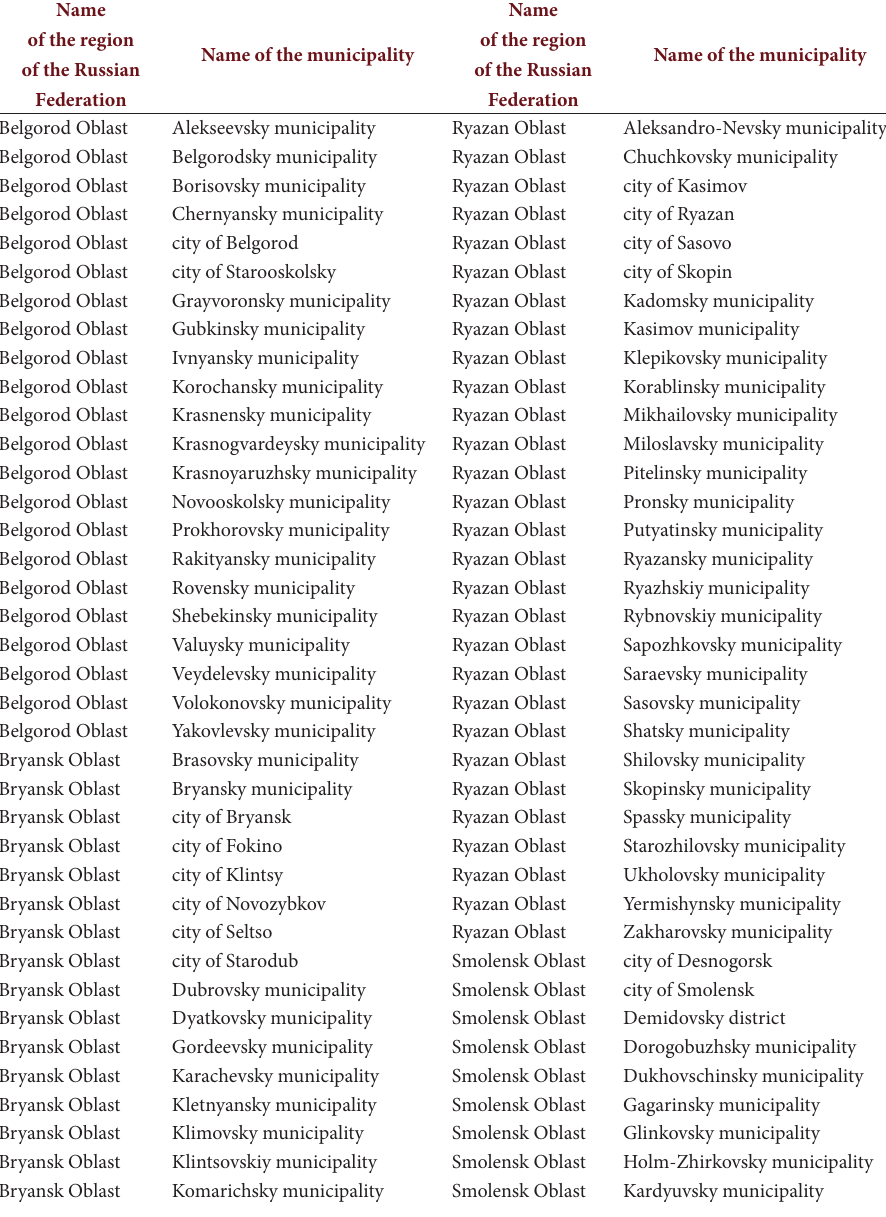
Table 1. List of administrative units and municipalities of the Central Federal District in Russia (ex- cluding the city of Moscow and the Moscow